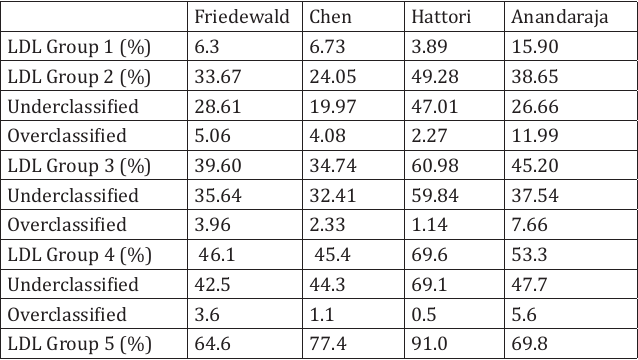
Figure 1 - Flowchart of the study.